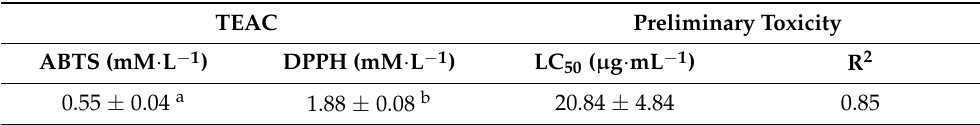
Table 2. Trolox equivalent antioxidant capacity of C. campinarensis EO for inhibition of ABTS • + and DPPH • radicals and preliminary toxicity against A. salina